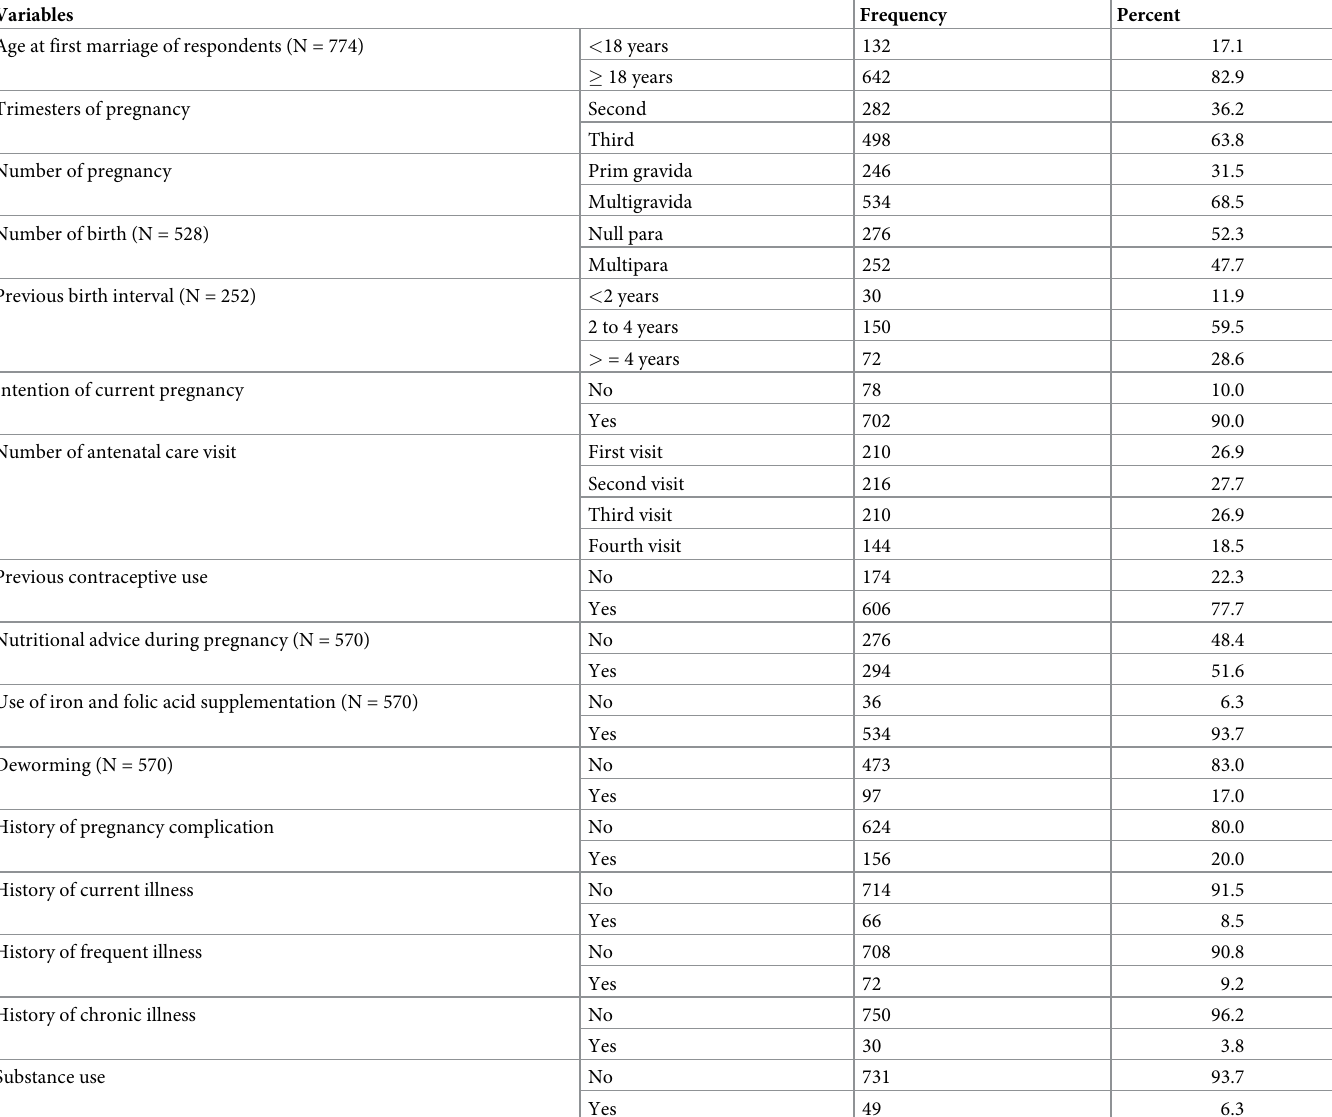
Table 2. Reproductive and medical characteristics of participants attending antenatal care services at public hospitals of West Wollega Zone, 2020 (N = 780).